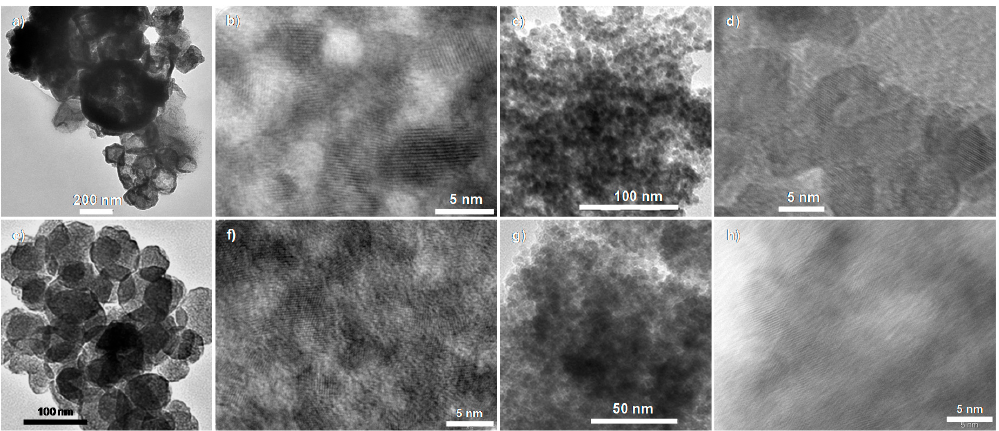
Figure 7. TEM images of ZnO -OR NPs, for ( a , b ) ZnO -OMe , ( c , d ) ZnO -OEt , ( e , f ) ZnO -O i Pr and ( g , h ) ZnO -O n Bu .